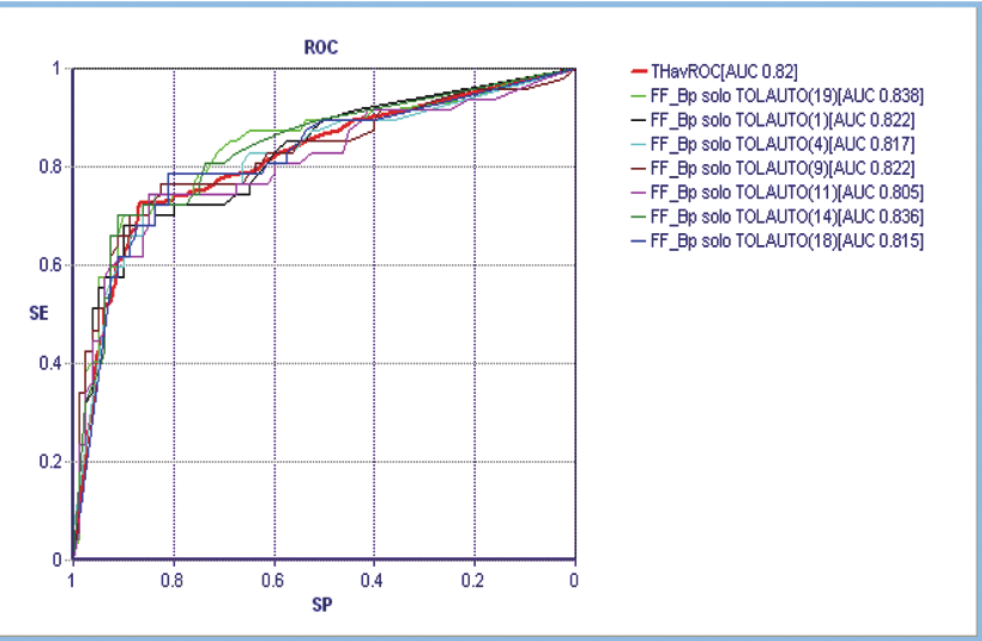
Fig. 2. ROC AUC of 7 testing experiments with